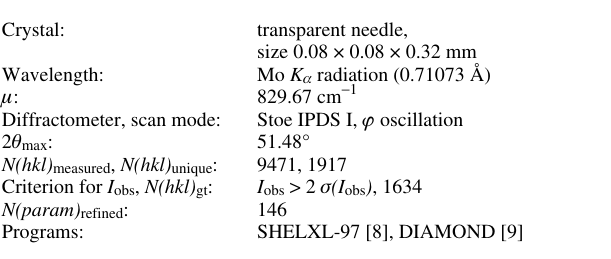
Table 1. Data collection and